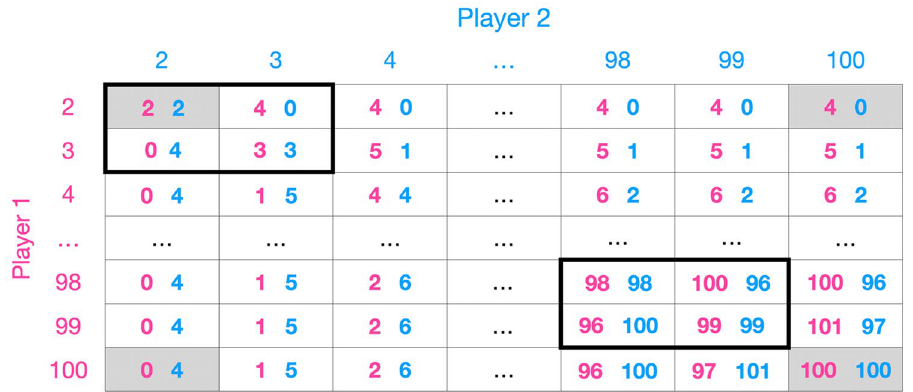
Figure 1. Payoff matrix of the Traveler’s Dilemma. Visualisation of the payoff scheme described by Eq. (1). For simplicity, the action space is Dilemma can be decomposed into a local and a global game. At a local level the game is a Prisoner’s Dilemma (black boxes). This happens when the action space is reduced to any pair of actions n and n 1 1 . While at the global level, we can observe a coordination game (gray boxes). This level is defined s R ≤ ≤ − as any pair of actions n and n